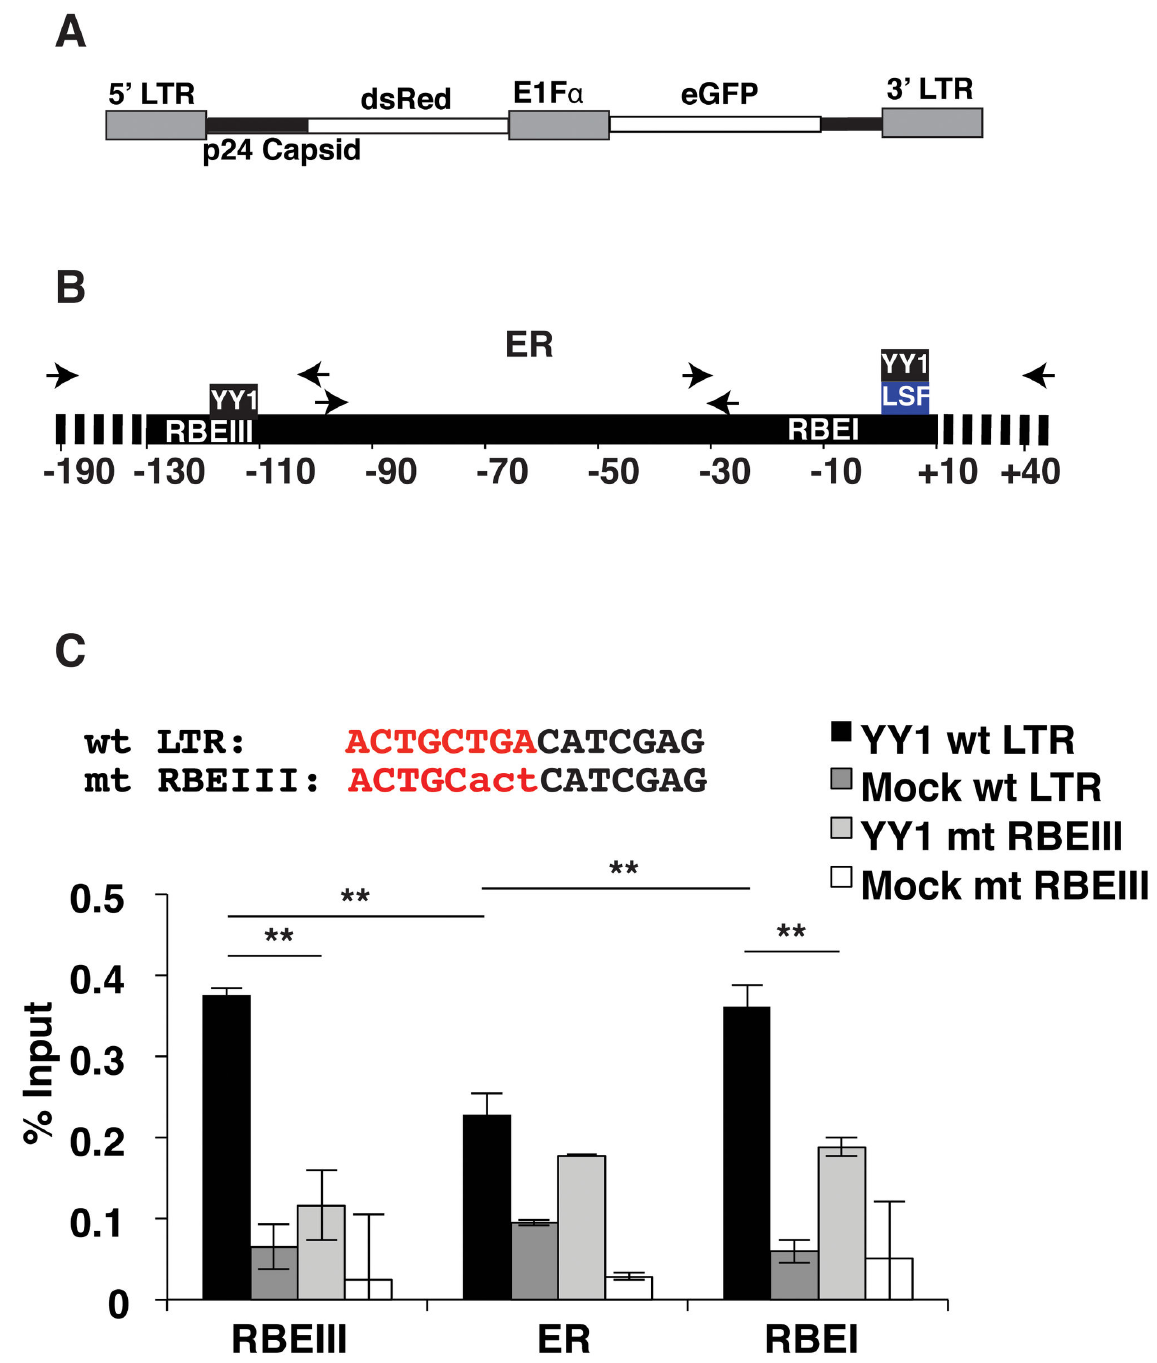
Figure 2. Mutations at RBEIII prevent binding of YY1 in Jurkat-tat cells. Panel A : Schematic representation of the pTY-LAI- dsRed reporter mini virus. The 5’ LTR controls expression of a p24 capsid-dsRed fusion, while the E1Fα promoter constitutively expresses eGFP. Panel B : Representation of primers used for ChIP analysis of the upstream RBEIII region, enhancer region (ER), and RBEI/ transcription start site region. Panel C : A representative pool of Jurkat-tat cells infected with the wild type and RBEIII/YY1 mutant reporter virus were used for ChIP analysis with YY1 antibody. Top, the core RBEIII sequence is shown in red and substitutions in the RBEIII/YY1 mutant indicated in lowercase. Bottom, Representative pools of Jurkat-tat cells infected with the wild type reporter virus or mutant RBEIII cell lines were used for ChIP analysis with YY1 antibody, using the primer sets indicated in Panel B. Error bars represent the standard deviation. ** Represents P values ≤ 0.01. doi: 10.1371/journal.pone.0077052.g002 PLOS ONE |